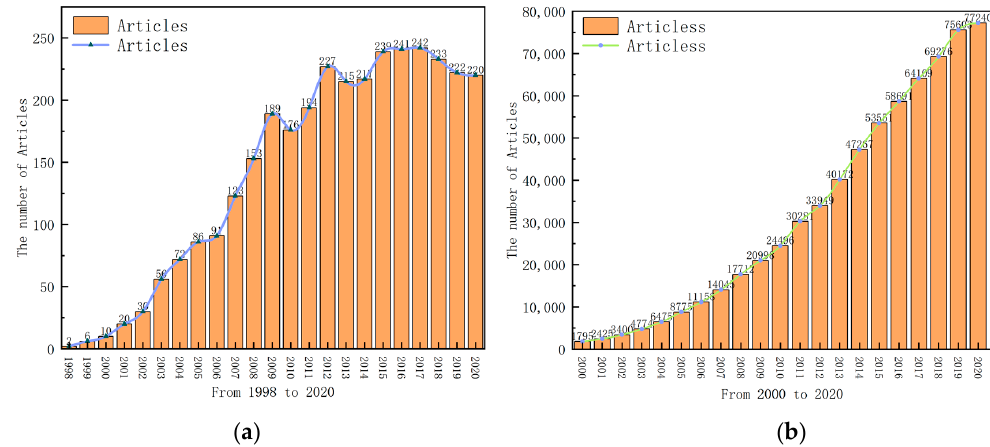
Figure 2. ( a ) The number of articles on “supercritical fluid for the synthesis of nanomaterials” and ( b ) the number of articles on “nanomaterials”.